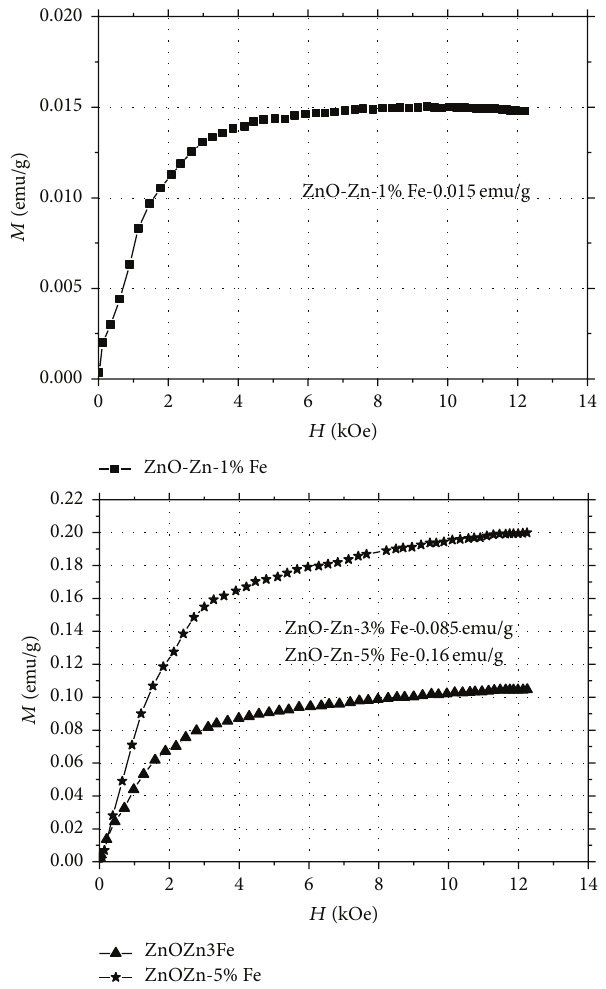
Figure 6: Magnetization change at room temperature in NP ZnO- Zn-Fe in relation to concentration of Fe.